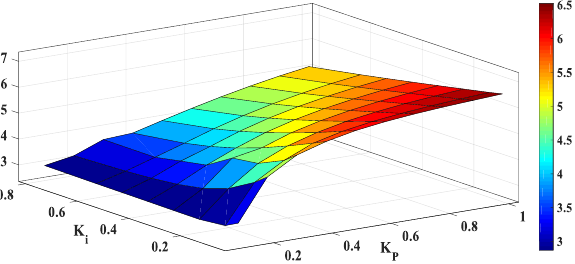
Figure 7. Maximum permitted delay for an EV aggregator with α 1 = 0.2 and τ M